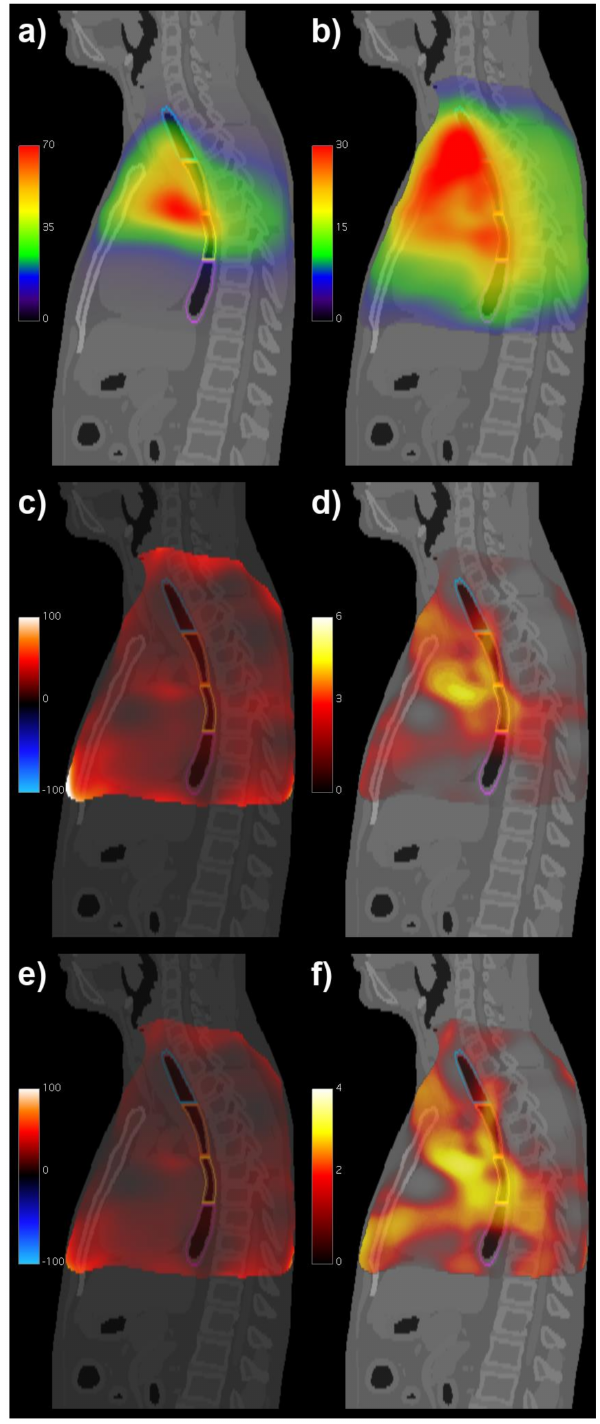
Figure 2. Voxel-based analyses results: sagittal computed tomography (CT) views fused with voxel- wise mean ( a ) and voxel-wise standard deviation ( b ) of biologically effective dose (BED, in Gy) maps; BED coefficient ( c ) and its significance (expressed as -log p ) ( d ) in the voxel-based GLM of radiation-induced esophagitis (RE), including treatment modality; BED coefficient ( e ) and its significance (expressed as -log p ) ( f ) in the voxel-based actuarial regression of RE, including induction chemotherapy and treatment modality. The contours of the esophageal subsites are superimposed on the CT images (blue: cervical esophagus, orange: upper thoracic esophagus, yellow: middle thoracic esophagus, and violet: lower thoracic